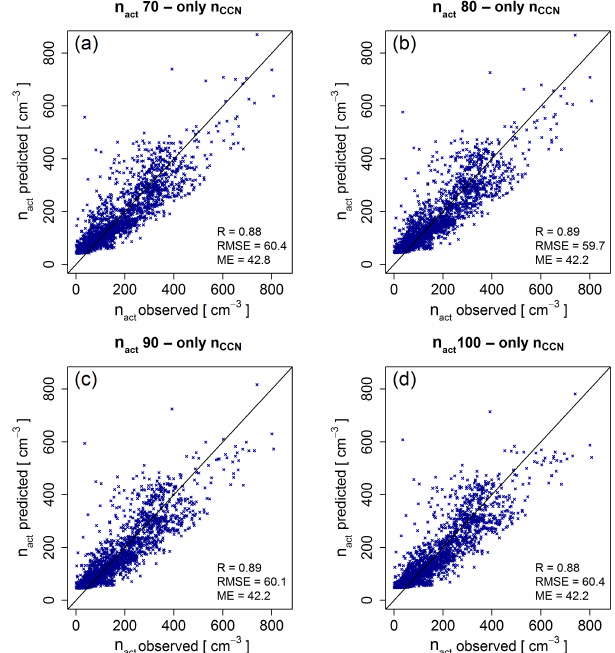
Figure 5. The number of cloud droplets calculated using different statistical models, plotted against the observed number of residuals. The model used for (a) included only the n CCN ; for (b) n CCN and updraught velocity are included in the model; in (c) all variables are included. In (d) all variables are included, but the log of the updraught velocity is used.